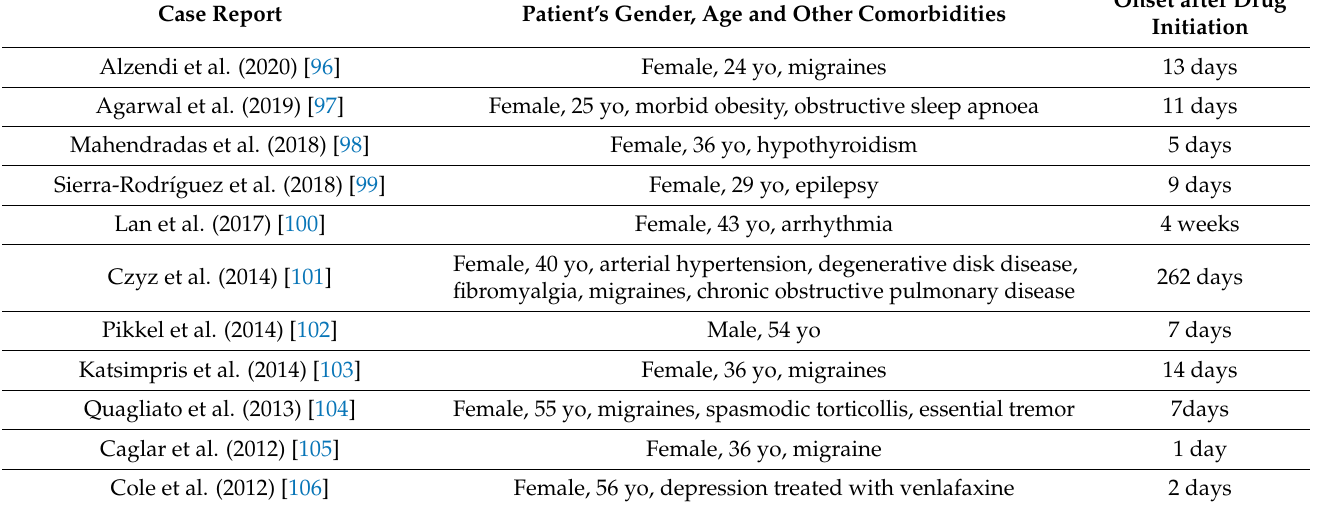
Table 2. A summary of currently reported topiramate-induced acute (primary) angle-closure or acute (primary) angle- closure glaucoma cases (in adult